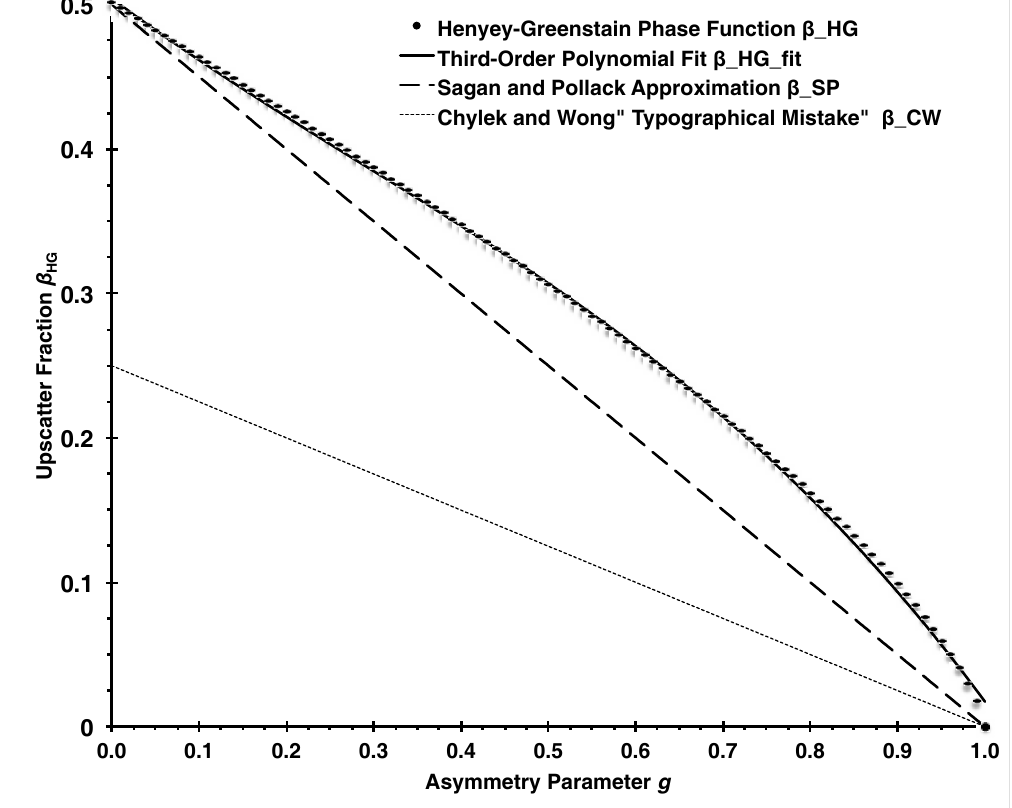
Figure 4. The Henyey-Greenstein average upscatter fraction β HG (solid dots), and a polynomial fit β HG _ fit (solid line) as function of asymmetry parameter g. In addition, a linear approximation (dashed line) given by Sagan and Pollack [28] originally for the backscatter, but also somewhat useful for the upscatter fraction is shown and the original β CW found in Chýlek and Wong [2], making the “factor of two” typographical error obvious.